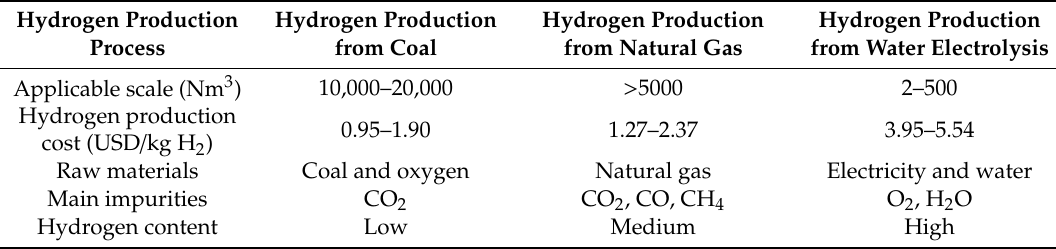
Table 2. Comparison of different hydrogen production processes.